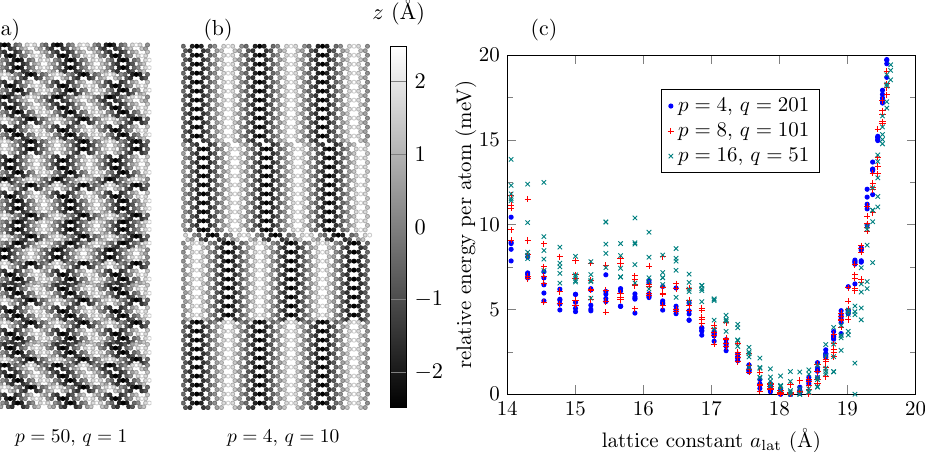
Figure 8. ( a ) Unit cell of a 50-AGONR with no ordered oxygen atoms over the surface ( q = 1). ( b ) Unit cell of a 40-AGONR with partially ordered oxygen atoms, with the order covering a length of q = 10 armchair lines. Periodicity is along the horizontal direction ( X -axis). Atoms are represented as balls in gray color levels to indicate their atomic height positions over the XY -plane. ( c ) Energy distribution of a 800-AGONR with partially ordered oxygen atoms at different levels, for q = 201 (highly ordered), 101, and